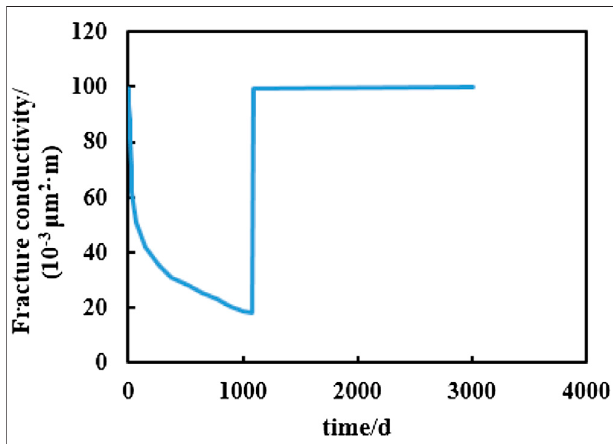
FIGURE 8 | Variation diagram of conductivity of recovery fracture.